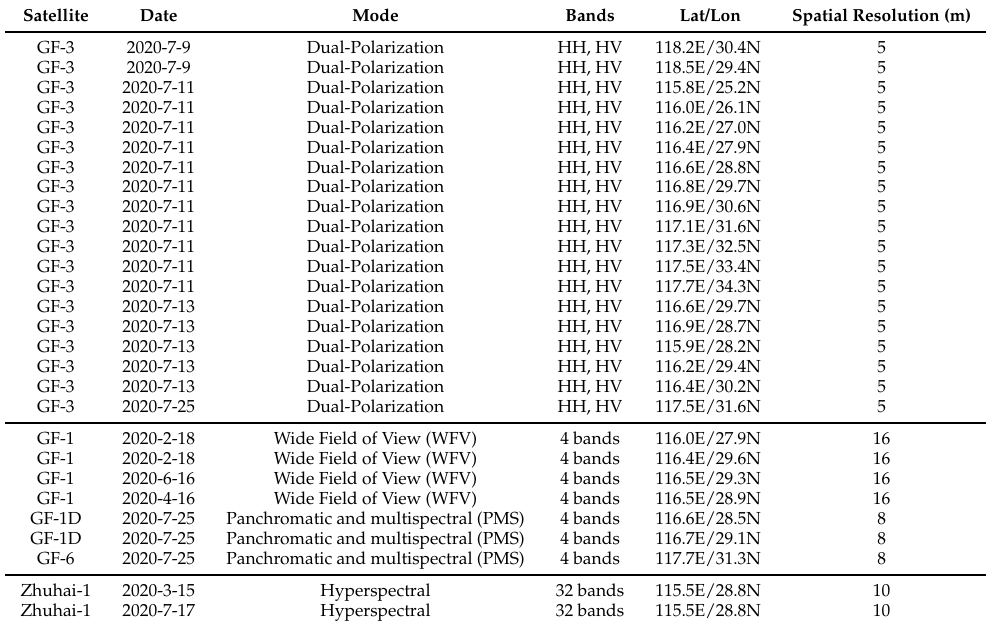
Table 1. The primary characteristics of the Remote-Sensing products employed in this study.